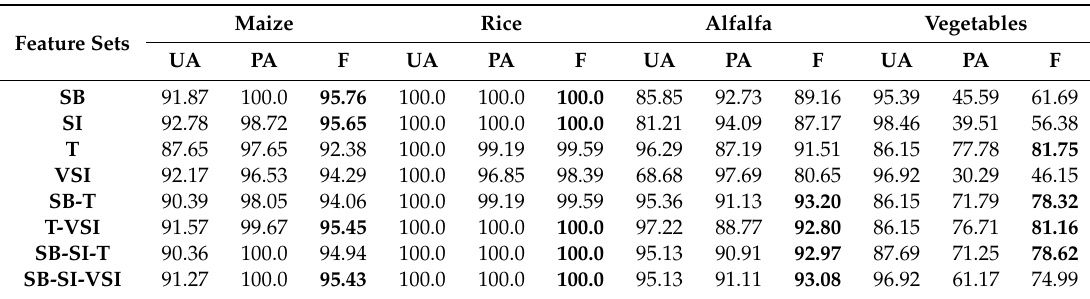
Table 6. Impact assessment of di ff erent feature sets in separating crops using RF-PSO. Bold values correspond to the highest F-scores (%).